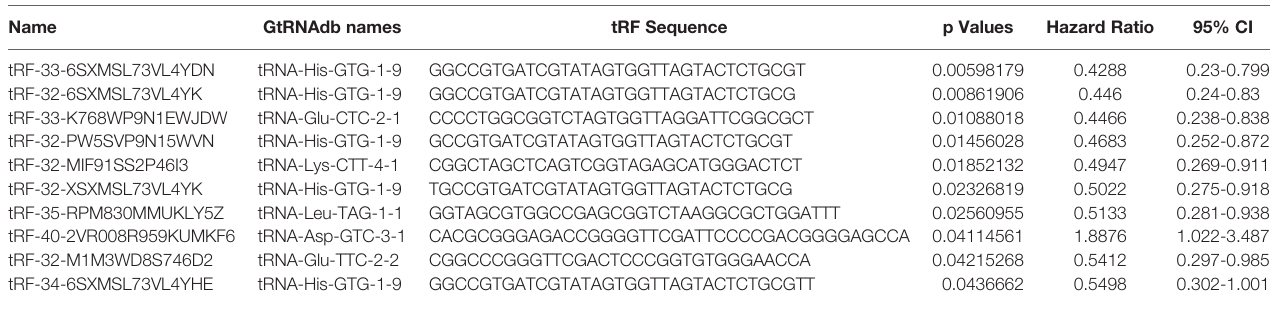
TABLE 2 | A list of top 10 tsRNAs with p-value less than 0.05 with hazard ratio (HR) and 95% con fi dence interval (CI) when the univariate Cox models were